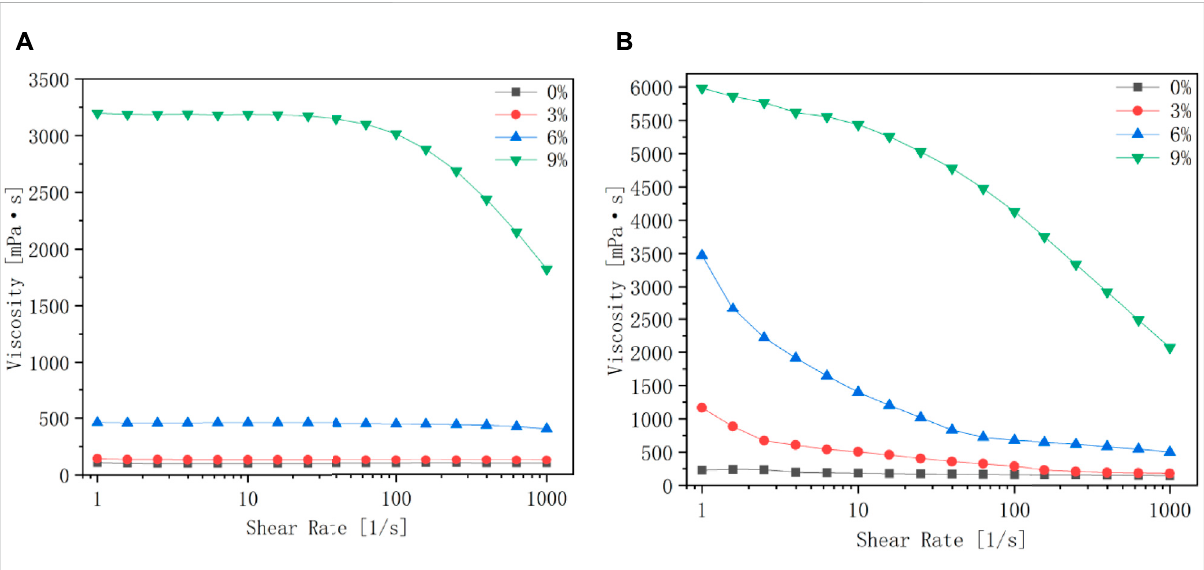
FIGURE 12 Variation of viscosity with shear rate for kerosene-based magnetic fl uids with different evaporation rates under different magnetic fi eld strengths. (A) is the magnetic fi eld strength at 0T; (B) is the magnetic fi eld strength at 0.2T.